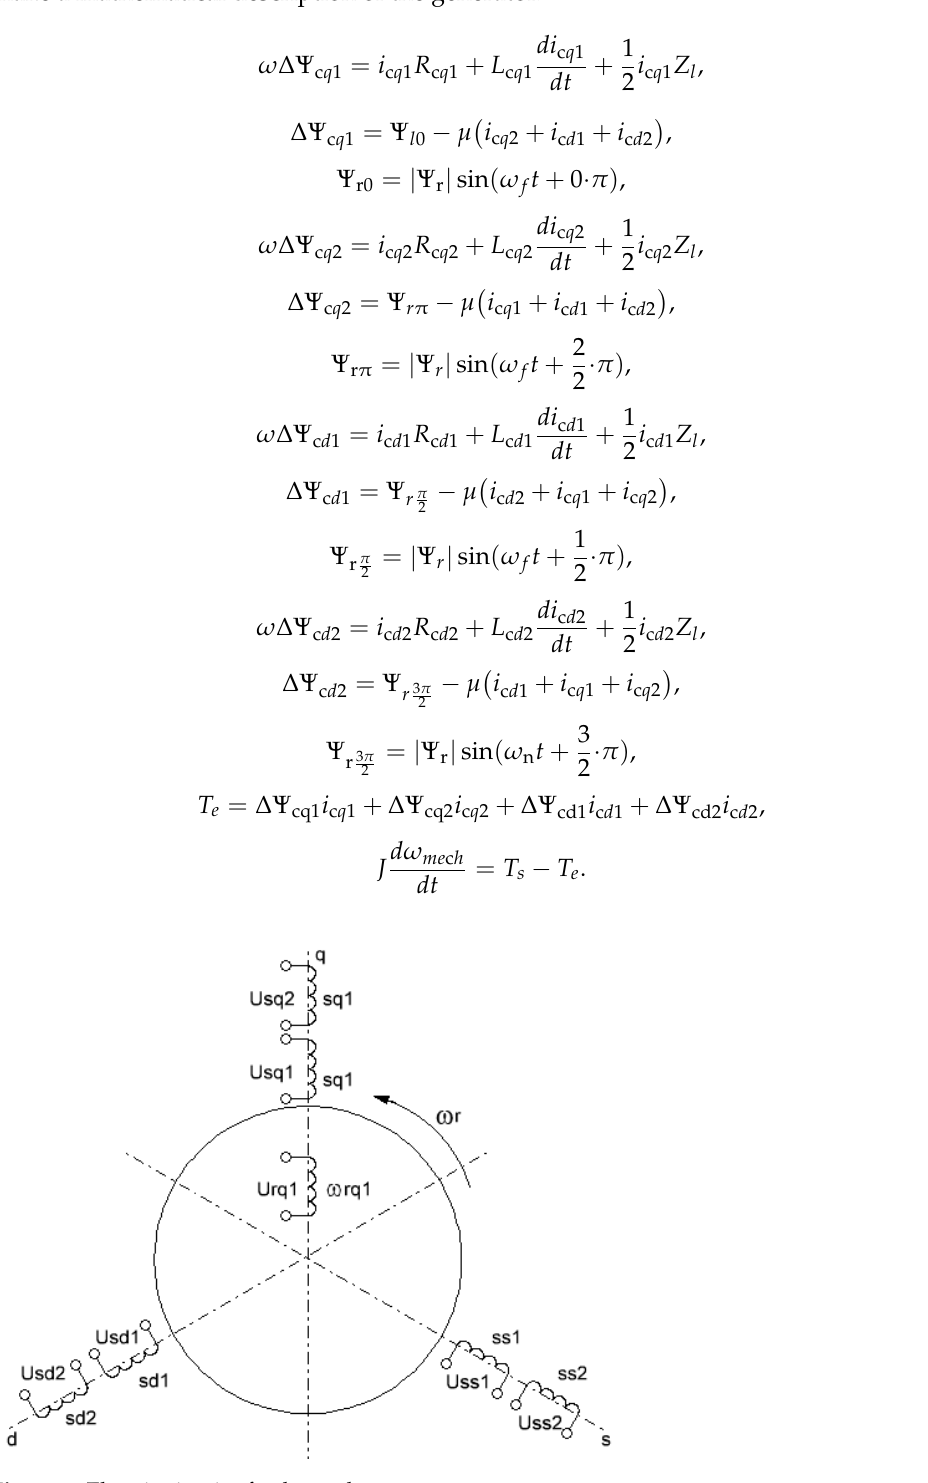
Figure 8. Electric circuit of a three-phase generator.